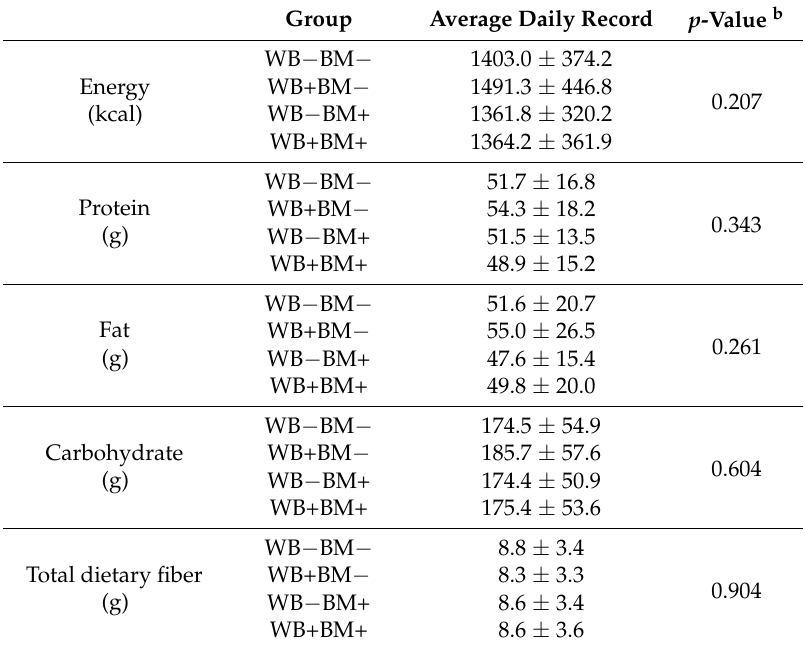
Table 4. Energy and nutrition intakes of subjects during the test period.